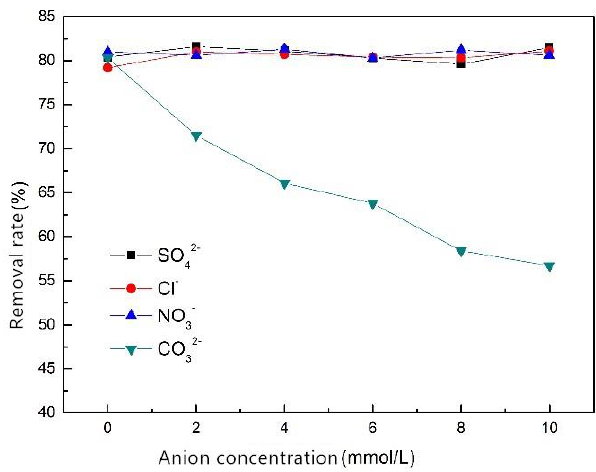
Figure 8. E ff ect of anion on phosphorus removal e ffi ciency of ZSFB composite fiber. Figure 8. Effect of anion on phosphorus removal efficiency of ZSFB composite fiber.